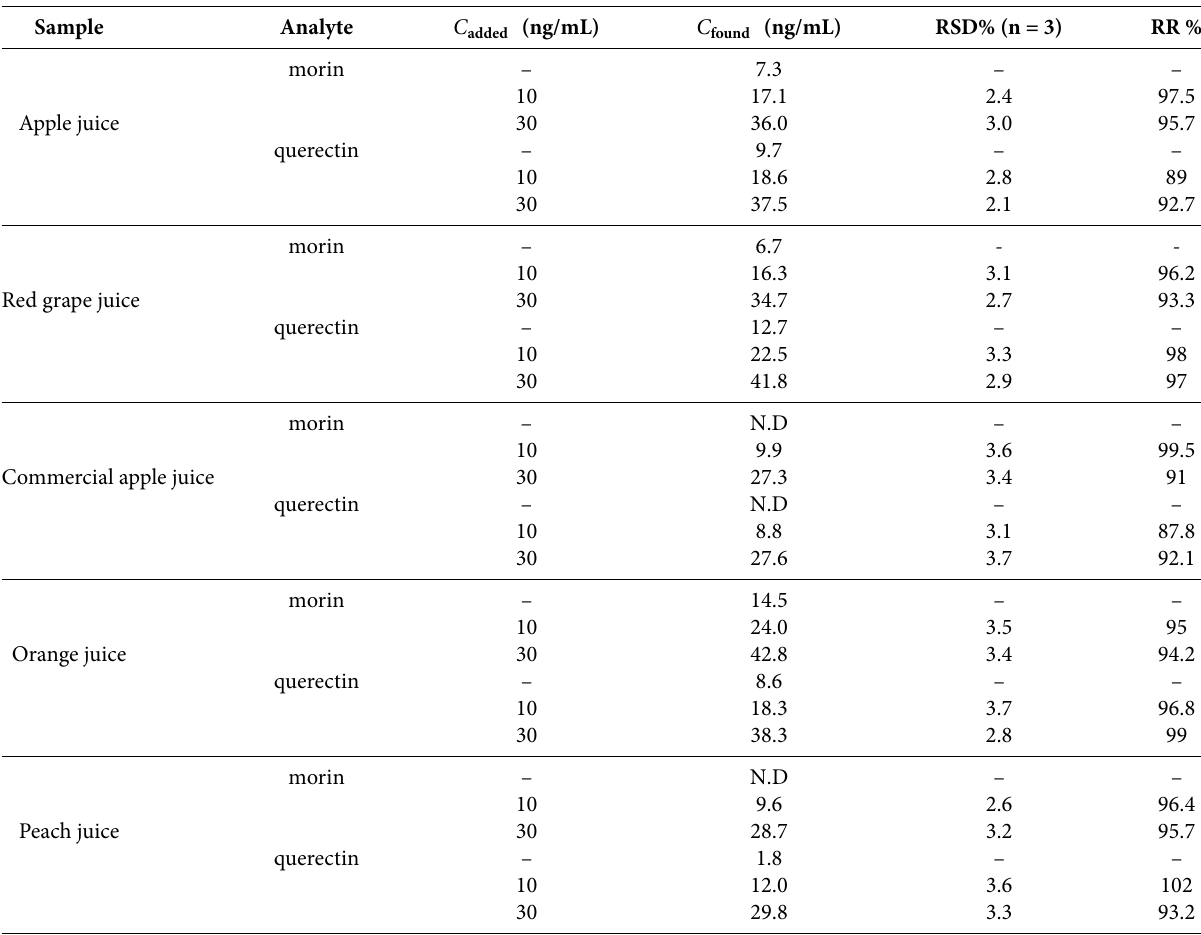
Table 3. The application of presented method for the determination of morin and querectin in fruit juices samples